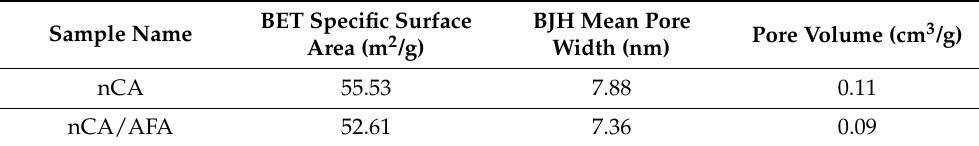
Table 2. BET surface area, BJI pore size, and pore volume for nCA and nCA/AFA.